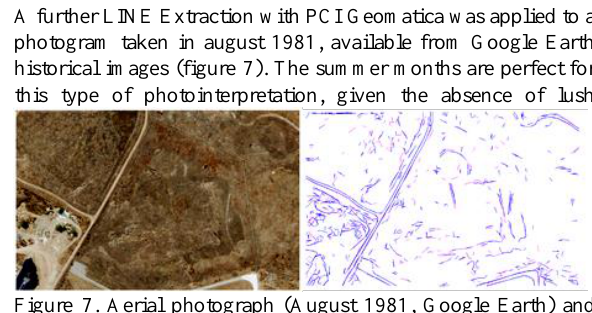
Figure 6 Edge Enhance Filter on a historical photogram (SARA 1932)